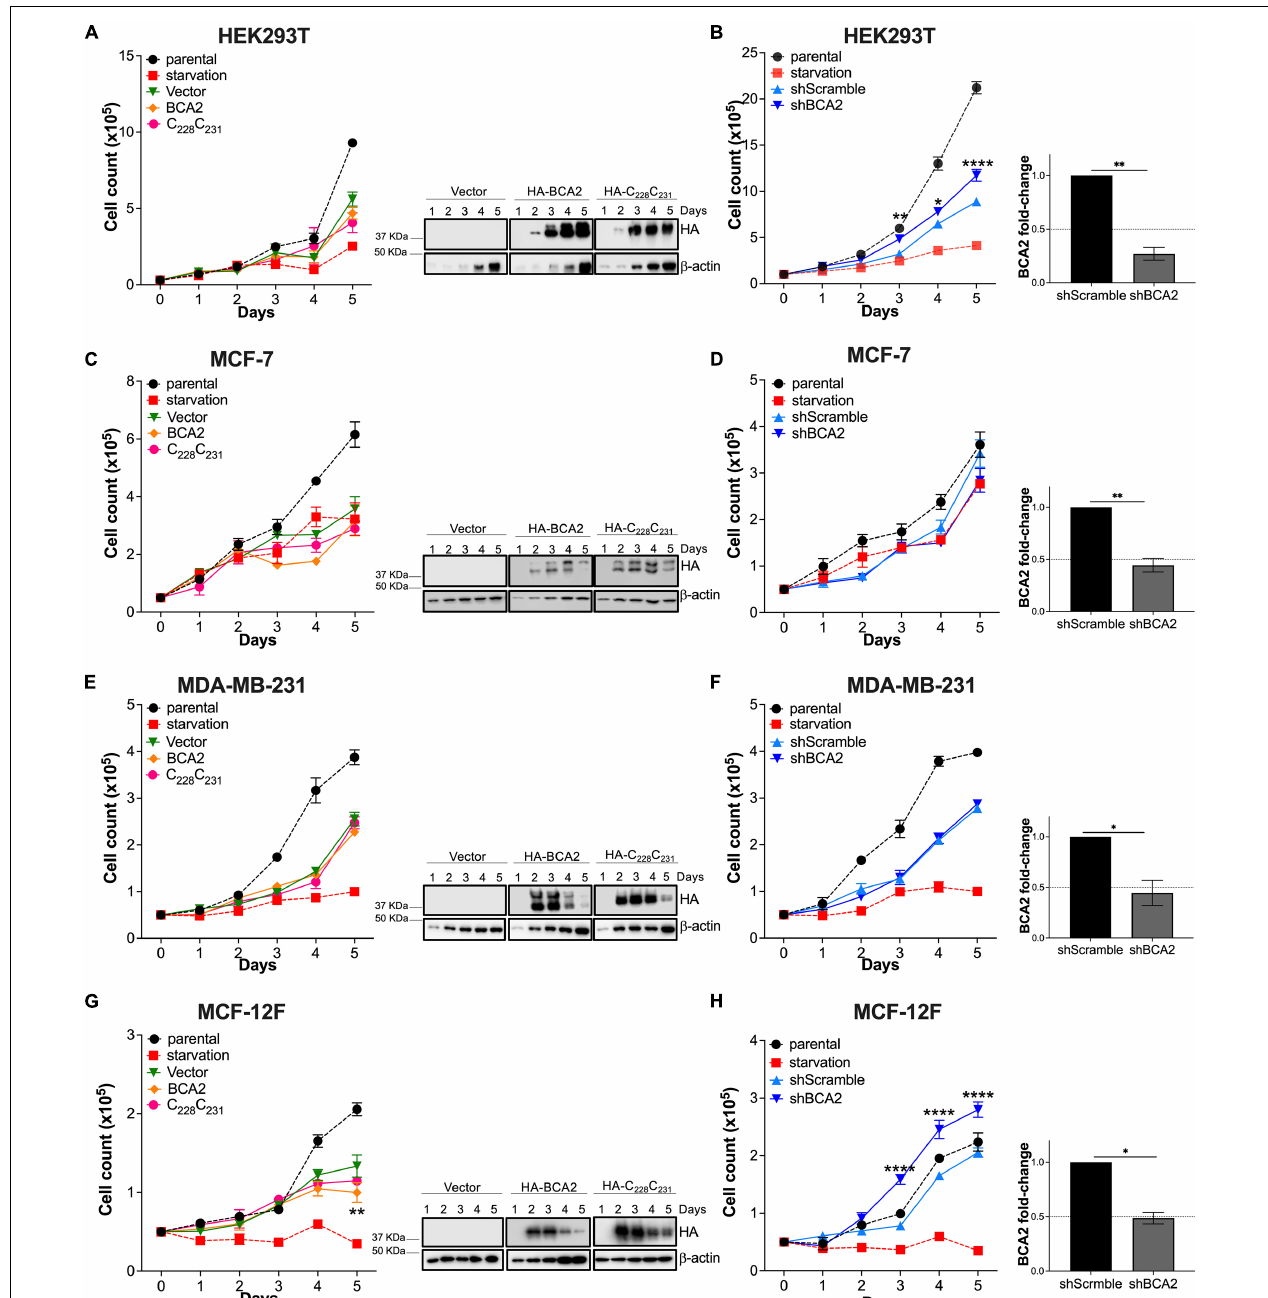
FIGURE 2 | Impact of BCA2 levels on cell proliferation. (A,C,E,G) Cells, including HEK293T cells (A) , MCF-7 (C) , MDA-MB-231 (E) , and MCF-12F (G) were transfected with constructs encoding for HA-BCA2, a BCA2 catalytic-defective mutant (HA-C 228 C 231 ) or an empty vector control. Cell proliferation was assessed by cell counting over a period of 6 days. As controls, parental cells and cells under nutrient deprivation were included. Representative western blots for the expression of HA-BCA2 and HA-C 228 C 231 are shown next to the graphs. (B,D,F,H) Similar experiments were performed in cells stably transduced with a scrambled shRNA or depleted of BCA2. BCA2 depletion was verified on the first and last day of analysis by RT-qPCR (right panels show BCA2 levels on day 5 of the assay). Dotted lines represent threshold for biological significance. Data correspond to the mean and SEM of 3 independent experiments. * p < 0.05, ** p < 0.01, **** p < 0.0001.